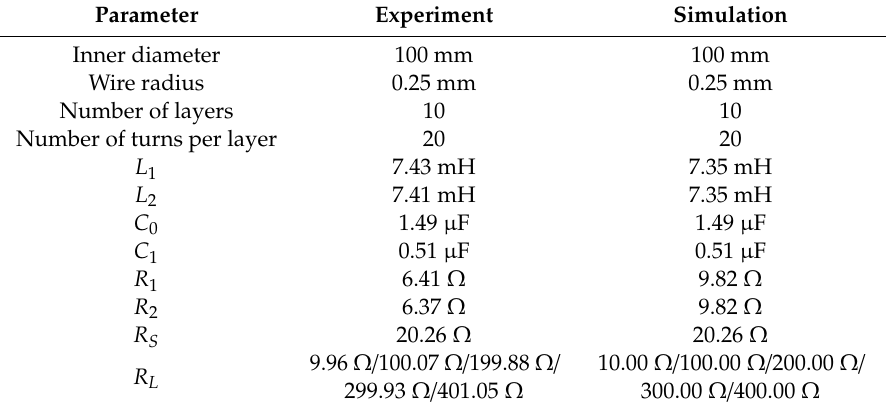
Table 1. The parameters of the passive wireless temperature measurement system.